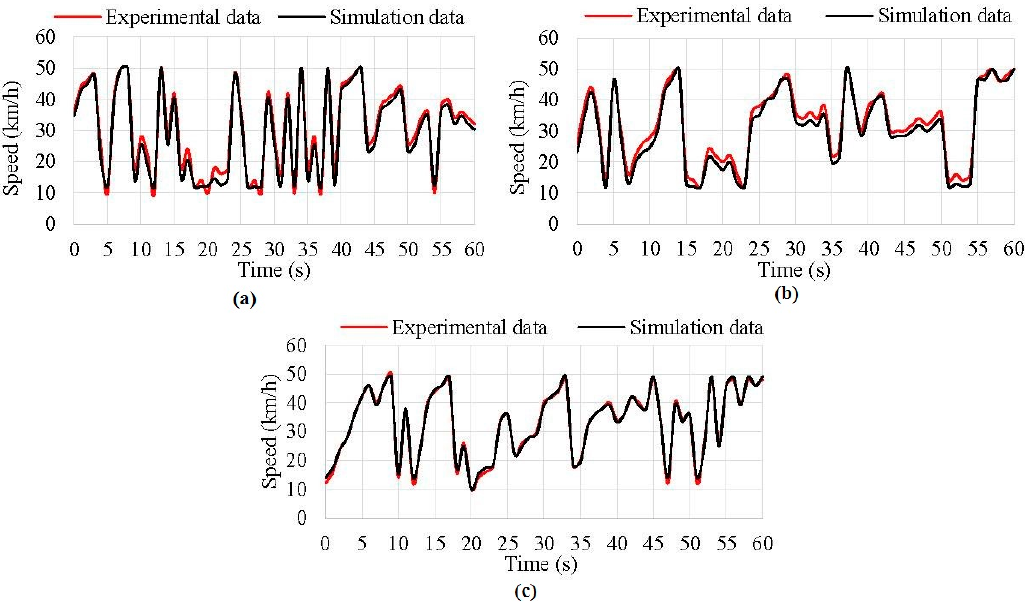
Figure 17. ( a ) Rolling speed simulation results at 0.8 bar; ( b ) Rolling speed simulation results at 1 bar; ( c ) Rolling speed simulation results at 1.2 bar.